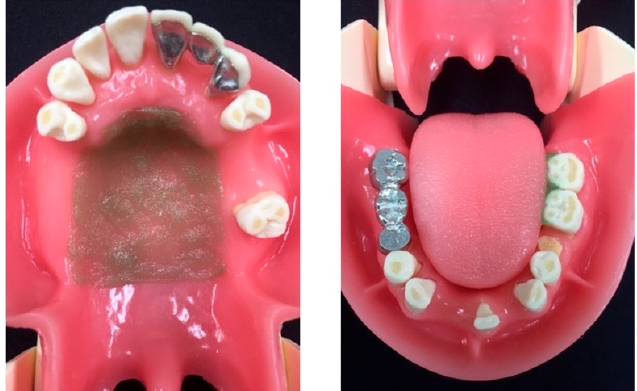
Figure 1. Pseudo-plaque attached to the simulator.